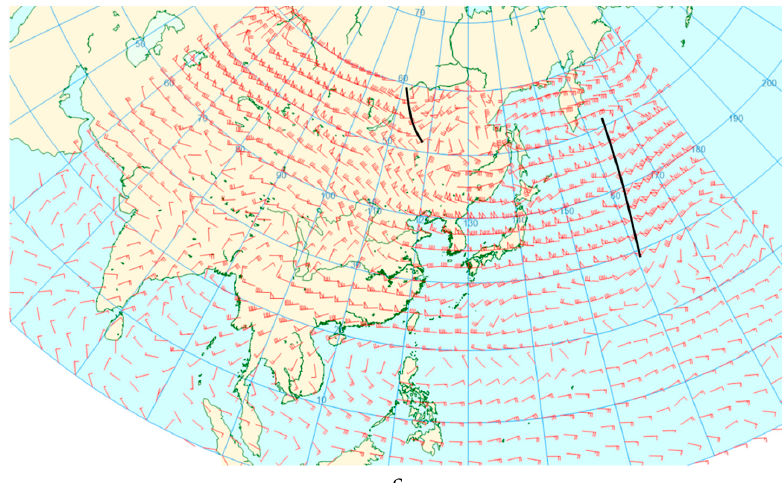
Figure 4. Results from each step of the objective longwave trough lines identification using wind field data from 1600 UTC on 30 April 2009: ( a ) extraction of cyclonic centers marked by “ ▲ ”; ( b ) extraction of the candidate longwave trough points marked with blue spots; and ( c ) identification of the longwave trough line (marked with black solid lines).